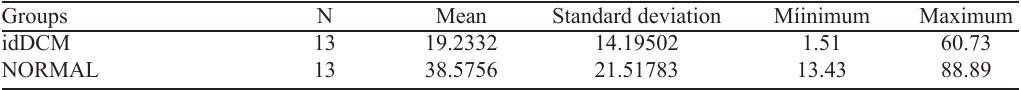
Table 5. Descriptive measures of variables collagen fibers of RVR in idDCM and NORMAL groups (percentage). Groups